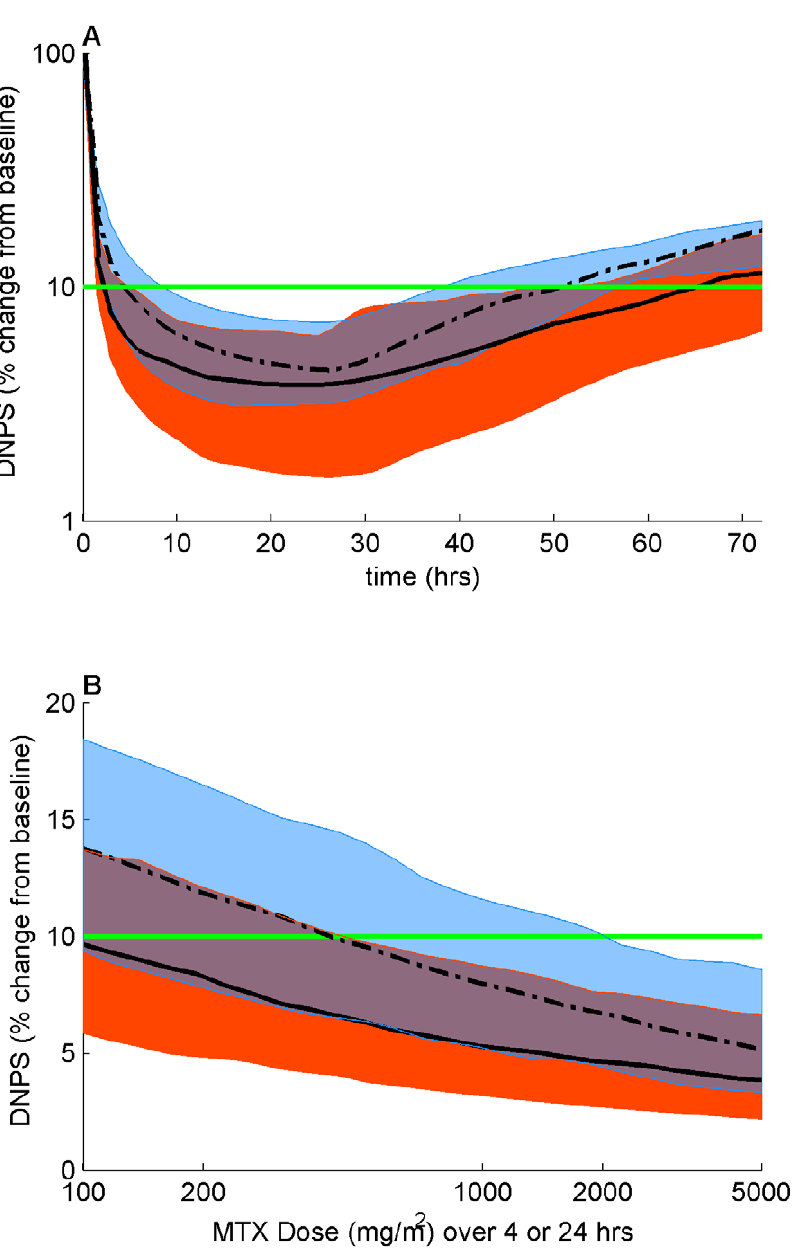
Figure 7. Simulations of the effects of lineage and dosage on model estimated DNPS activity. The curves represent the median and the shaded regions represent the quartiles of the results from the respective simulated patient populations. ( A ) Simulated percent change in DNPS vs time after a 1 g/m 2 dose of MTX. Solid curve and Red shading: B-lineage Hyperdiploid; Dashed curve and Blue shading: T-lineage. ( B ) Simulated percent change in DNPS at 42 hrs vs Dose. Solid curve and Red shading: 24 hr MTX infusion; Dashed curve and Blue shading: 4 hr MTX infusion.